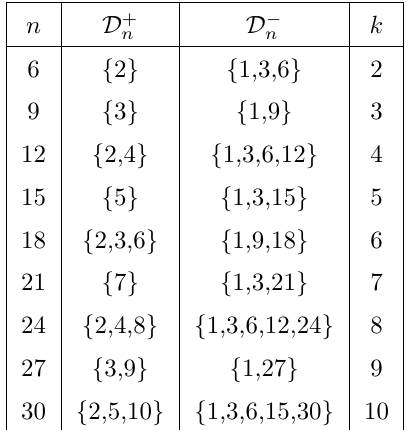
Table 4 . All solutions for N A = 2 and n (cid:20) 30 of the M k family. They are de(cid:12)ned by n ((cid:12)rst column) and the set D + (second column), from which one gets (cid:8) + n is for completeness, and it is unique due to (3.19). The last column speci(cid:12)es the integer k of the solution 3.4.3.